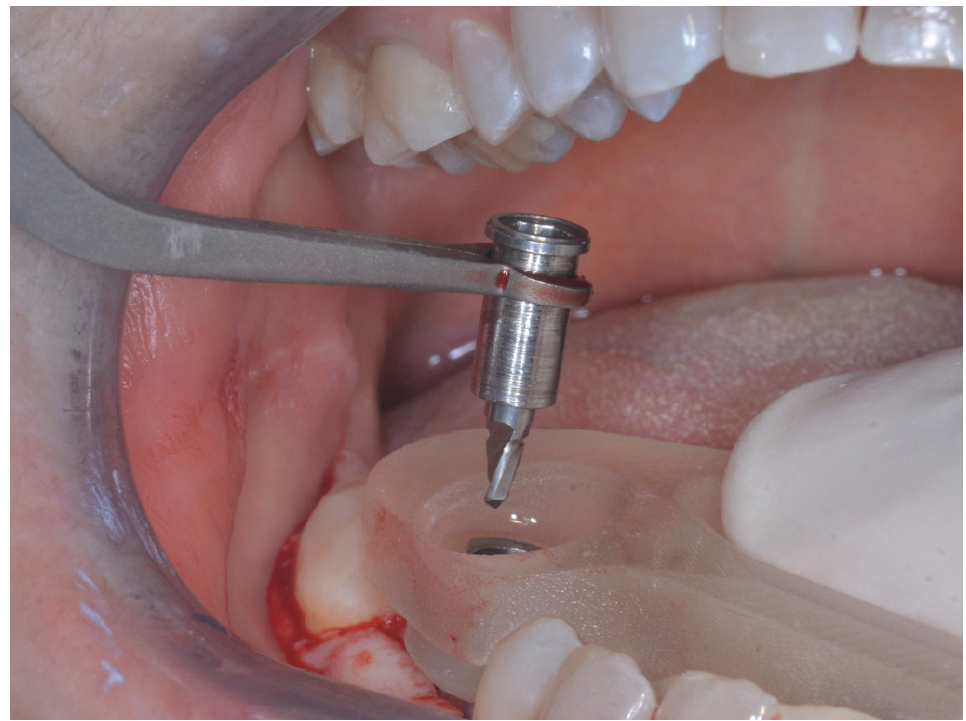
Figure 9. Intraoperative view of the progressive working drills (working depth 3 mm; diameter 2 mm).